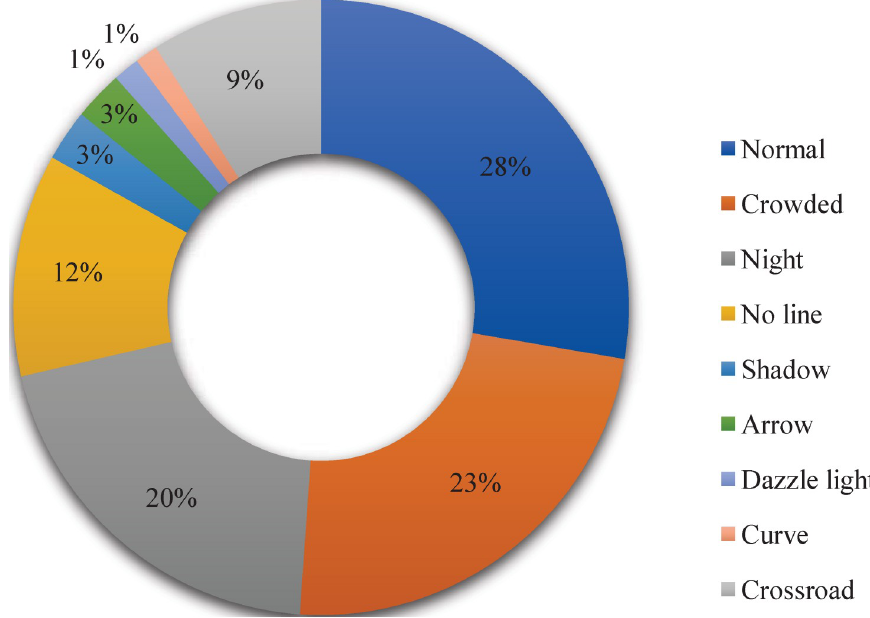
Fig 6. Scenarios and their